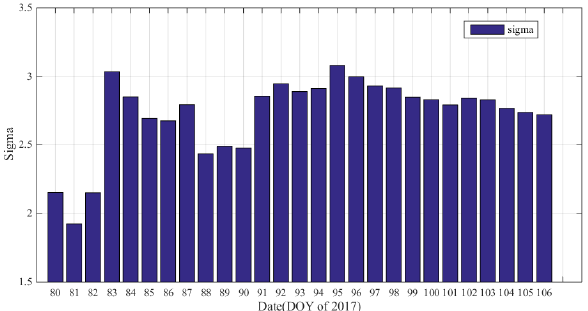
Figure 11. The v i g  results on different days. Figure 11. The σ vig results on different days. σ Figure 11. The vig results on different days.